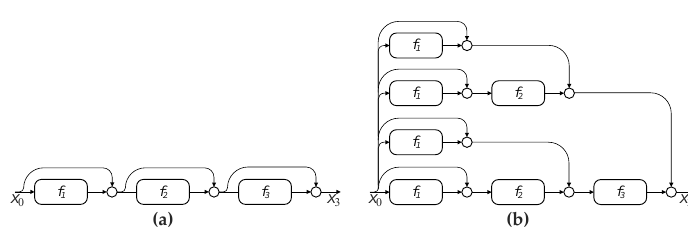
Figure 2. Illustration of a 3-block ResNet. ( a ) The conventional representation based on Equation (5). ( b ) The unraveled view with 2 3 implicit paths connecting input to output based on Equation (6). Circular nodes denote